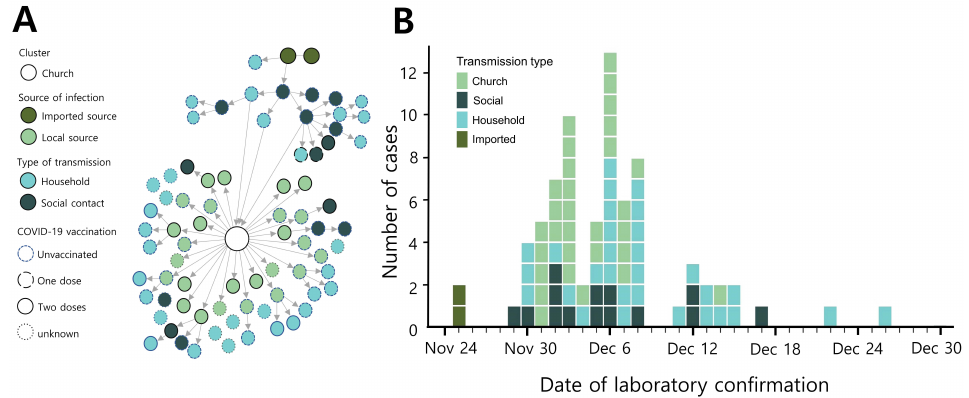
Figure 1. Transmission of the omicron variant of COVID-19 in South Korea in 2021. Transmission chain ( A ) and epidemic curve ( B ) of laboratory-confirmed SARS-CoV-2 Omicron variant infection associated with the first local outbreak ( n = 76) in South